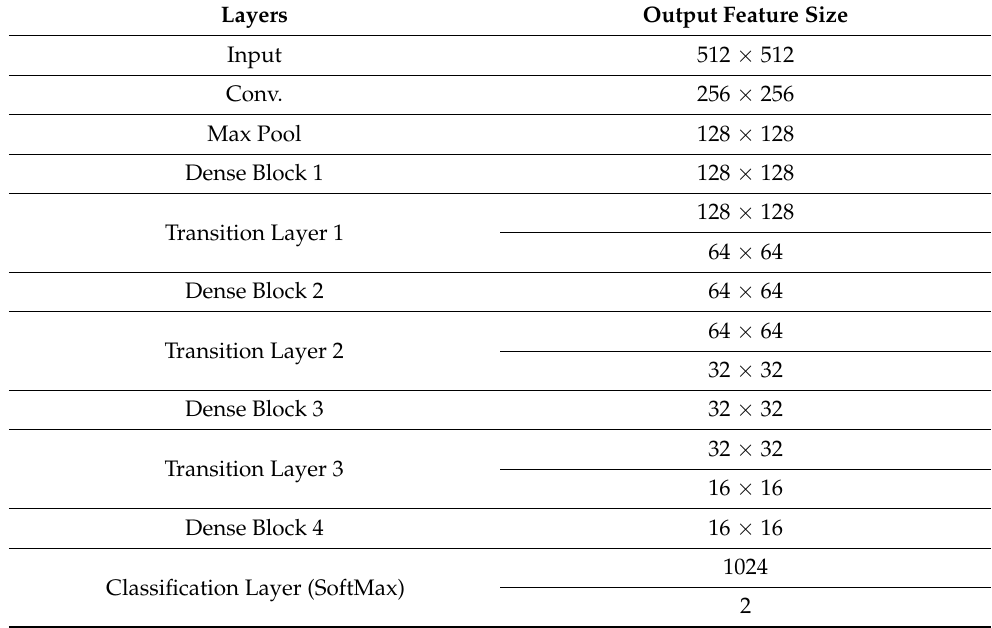
Table 1. Output feature map sizes of the three DenseNet